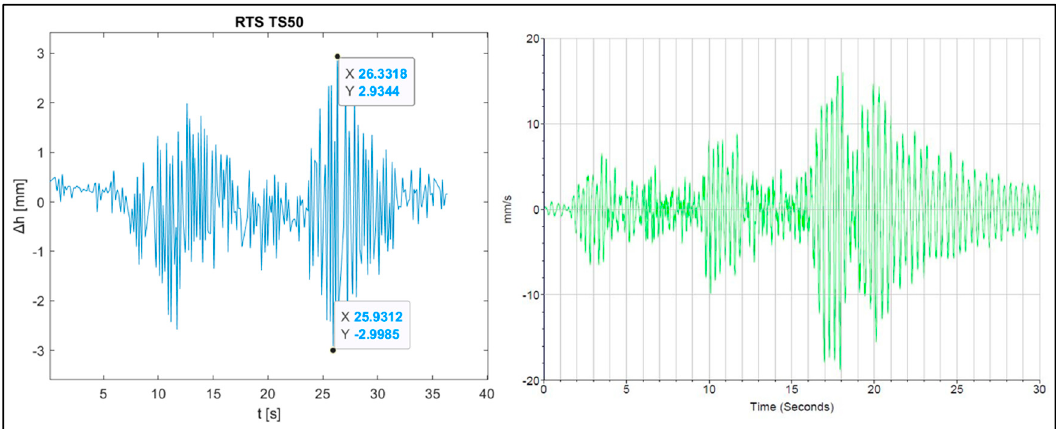
Figure 7. Comparison between graphs of vertical displacement (left) and vibration velocity (PPV V) (right).